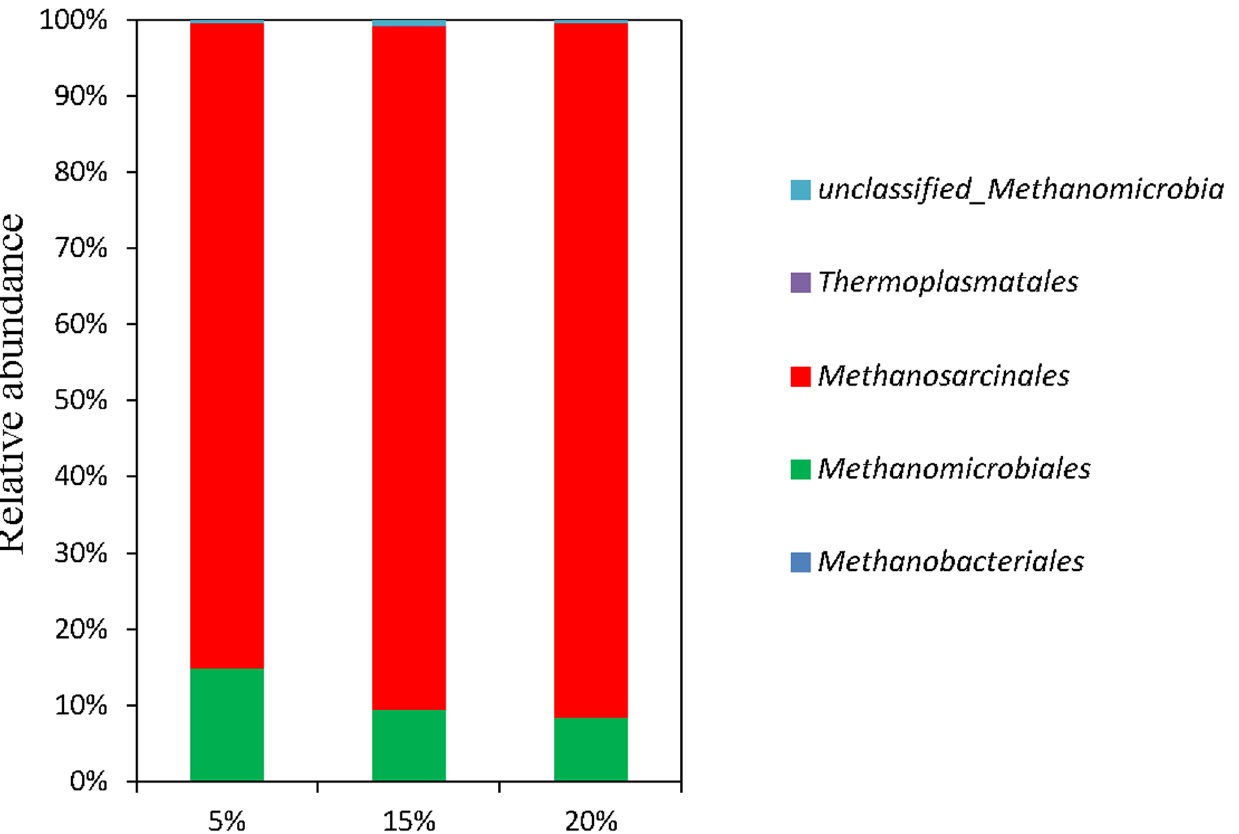
Figure 2. Taxonomic compositions of methanogens at order level in each sample retrieved from pyrosequencing.